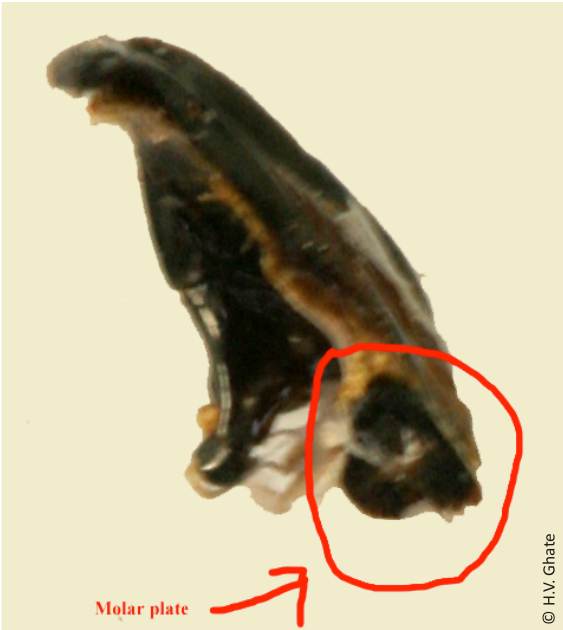
Image 15. Mandible of Apiocephalus to show molar plate, marked